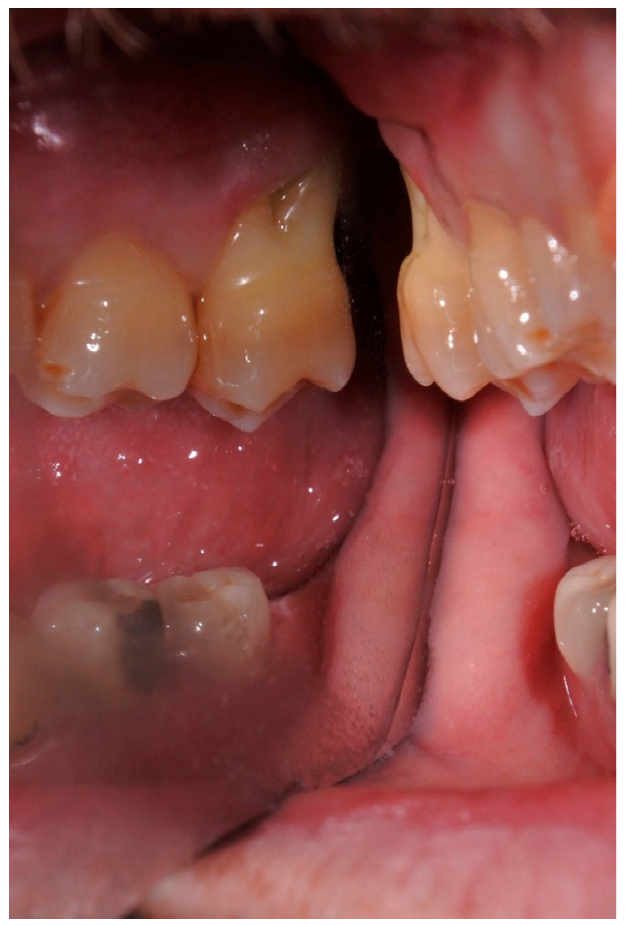
Figure 1. Intraoral photograph of tooth 1.7. with complete furcal exposure.